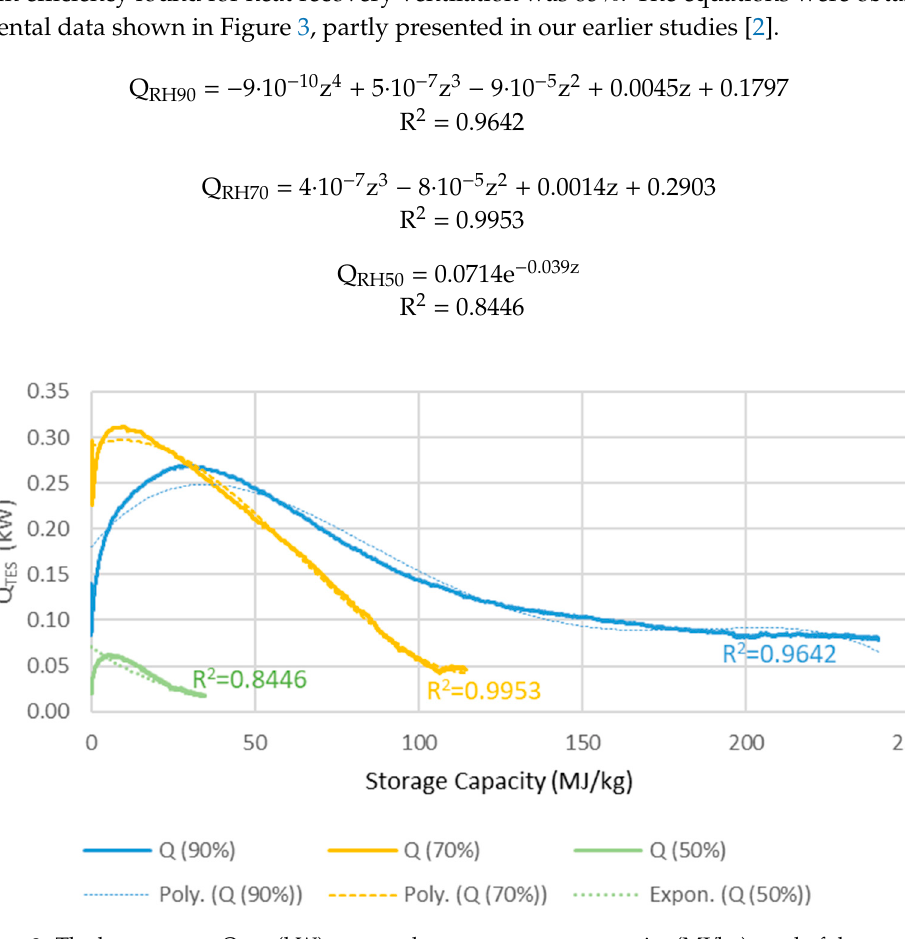
Figure 3. The heat output, Q TES (kW), versus the energy storage capacity (MJ / kg) used of the reactor in a 100 m 2 house.